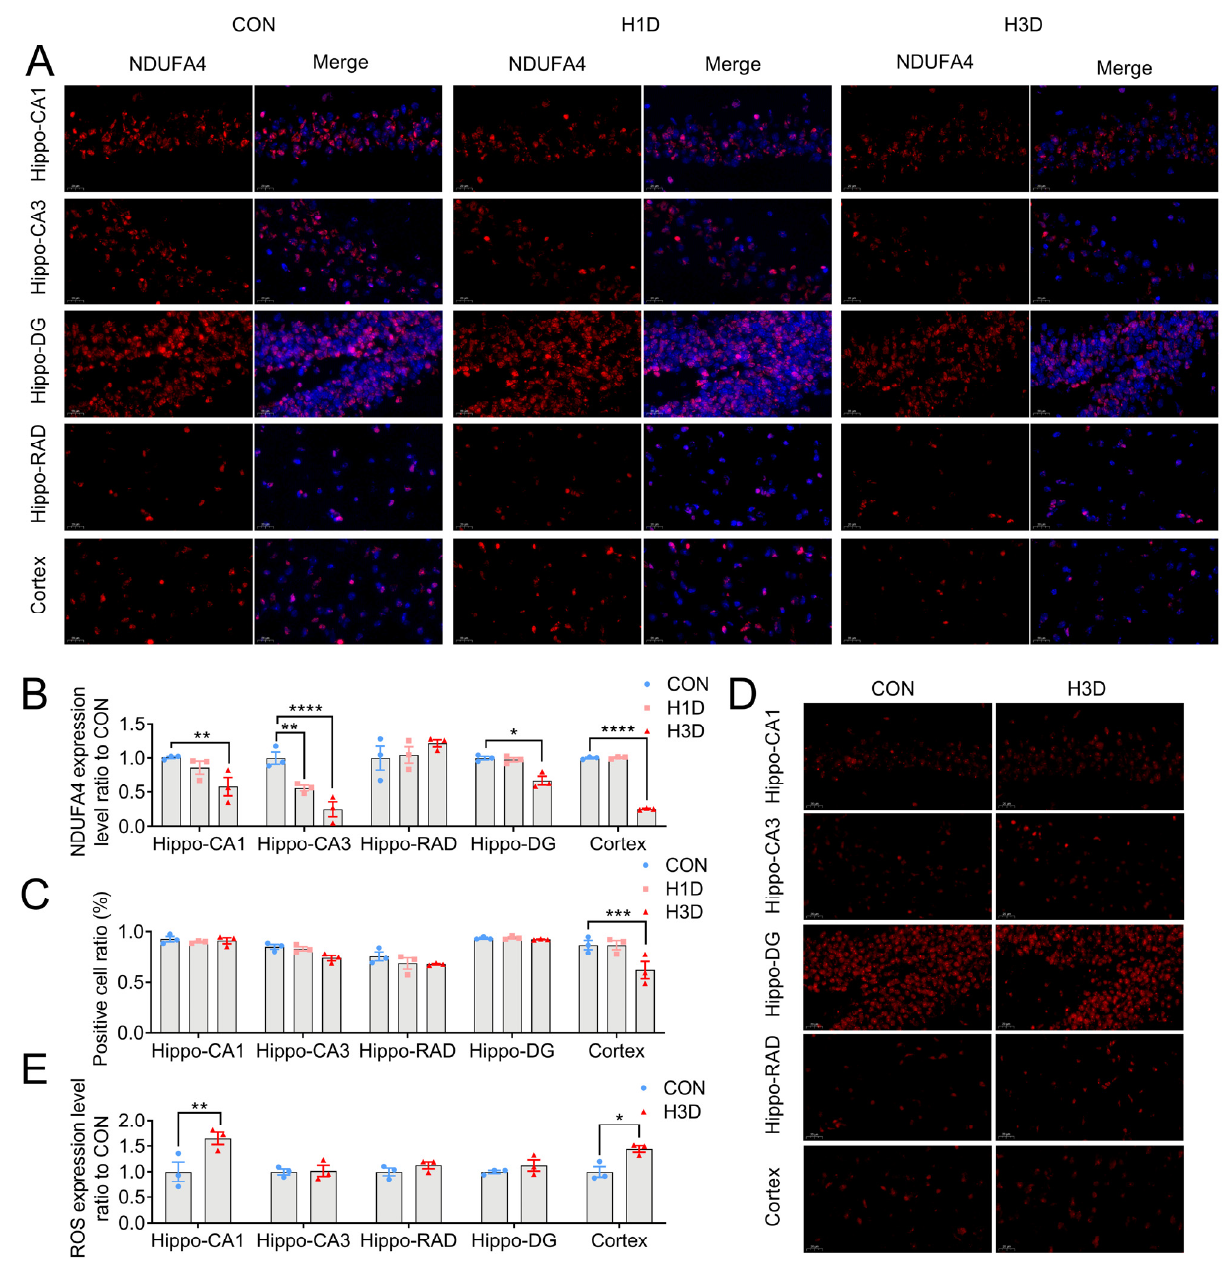
Figure 6. Hypoxic stress caused mitochondrial complex IV dysfunction by downregulating NDUFA4 expression. ( A ) Representative immunofluorescence images of NDUFA4 (red) in the hippocampus (CA-1, CA-3, DG, RAD) and cortex of the different groups. Nuclei are stained in blue (DAPI). ( B ) Quantification of the NDUFA4-positive area based on immunofluorescence staining sections by ImageJ Pro Plus 6.0 software. Statistical analysis of the fluorescence intensity of NDUFA4 was conducted on three slices from three animals per group. Data are expressed as the means ± SEM (two-way ANOVA). ** p < 0.01 H1D vs. CON, * p < 0.05, ** p < 0.01, **** p < 0.0001 H3D vs. CON (n = 3). ( C ) The ratio of positive cells based on immunofluorescence staining sections by ImageJ software. Data are expressed as the means ± SEM (two-way ANOVA). *** p < 0.001 H3D vs. CON (n = 3). ( D ) Representative immunofluorescence images of ROS (red) in the hippocampus (CA1, CA3, DG, RAD) and cortex of the different groups. Nuclei are stained in blue (DAPI). ( E ) Quantification of the ROS-positive area based on immunofluorescence staining sections by ImageJ Pro Plus software. Data are expressed as the means ± SEM (two-way ANOVA). * p < 0.05, ** p < 0.01 H3D vs. CON (n = 3).